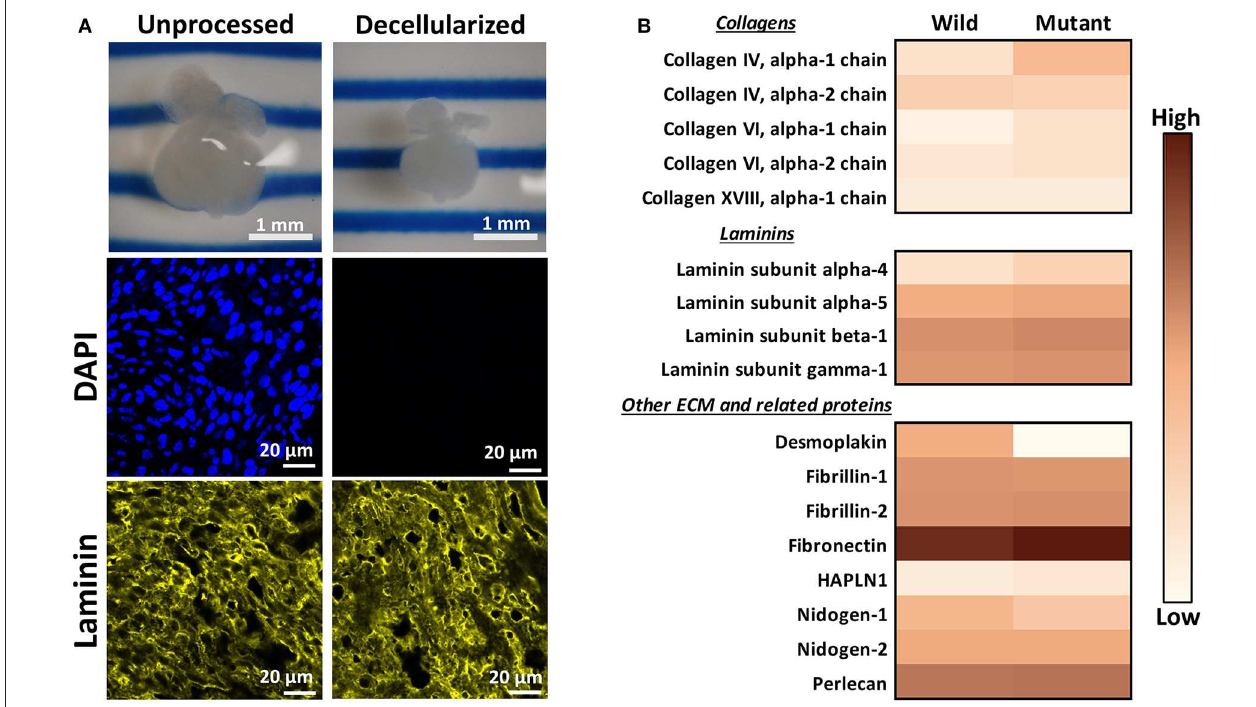
FIGURE 1 | Decellularization creates ECM-rich hearts for proteomic assessment. (A) Top: Image of the same embryonic heart before and after decellularization. Middle: DAPI staining demonstrating removal of nuclear materials from tissue post-decellularization. Bottom: Immunostaining demonstrating preservation of laminin throughout the decellularization process. DAPI and Laminin scale bars: 20 µ m. Images shown are representative of three biological replicates. Laminin staining used Alexa Fluor 647 dye but was pseudo-colored yellow for ease of comparison across graphics. (B) Heat map displaying ECM proteins detected in mass spectrometry analysis with at least one average spectral count per group. Color is based on the average spectral count value of three biological